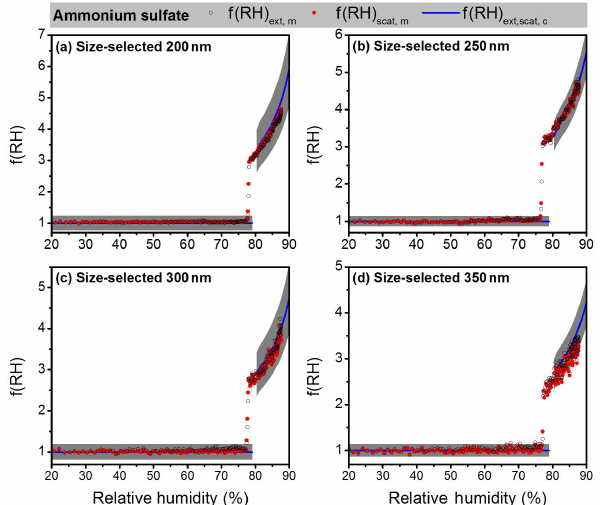
Figure 6. RH dependence of extinction and scattering enhancement for size-selected (a) 200nm, (b) 250nm, (c) 300nm, and (d) 350nm dry diameter ammonium sulfate particles. The black circles and red dots represent the measured extinction ( f (RH) ext , m ) and scatter- ing ( f (RH) scat , m ) hygroscopic enhancement, respectively. The blue lines represent the model calculations with Mie theory, and the grey areas represent the uncertainty bounds estimated from the measured size distribution of size-selected particles from the SMPS.